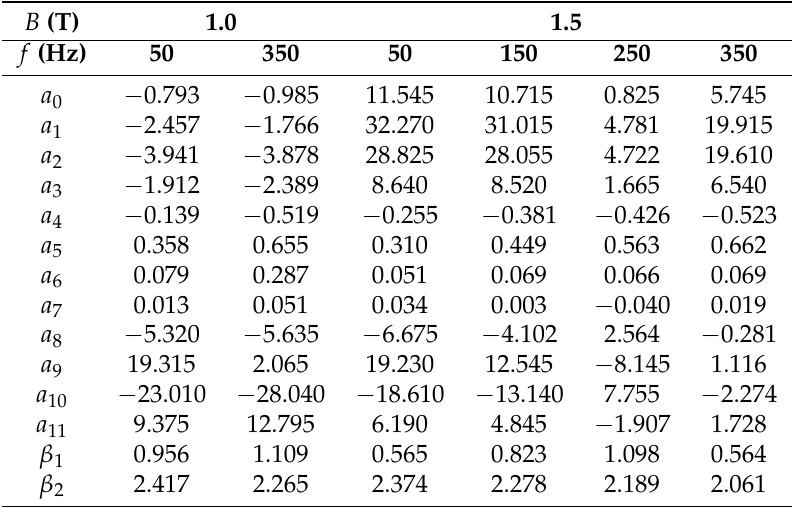
Table 4. Parameters of the describing functions for